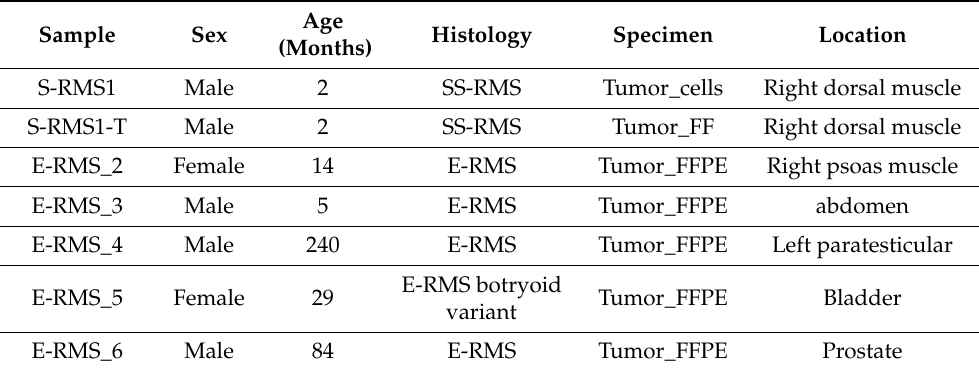
Table 4. Demographic and clinical features of samples included in DNA methylation